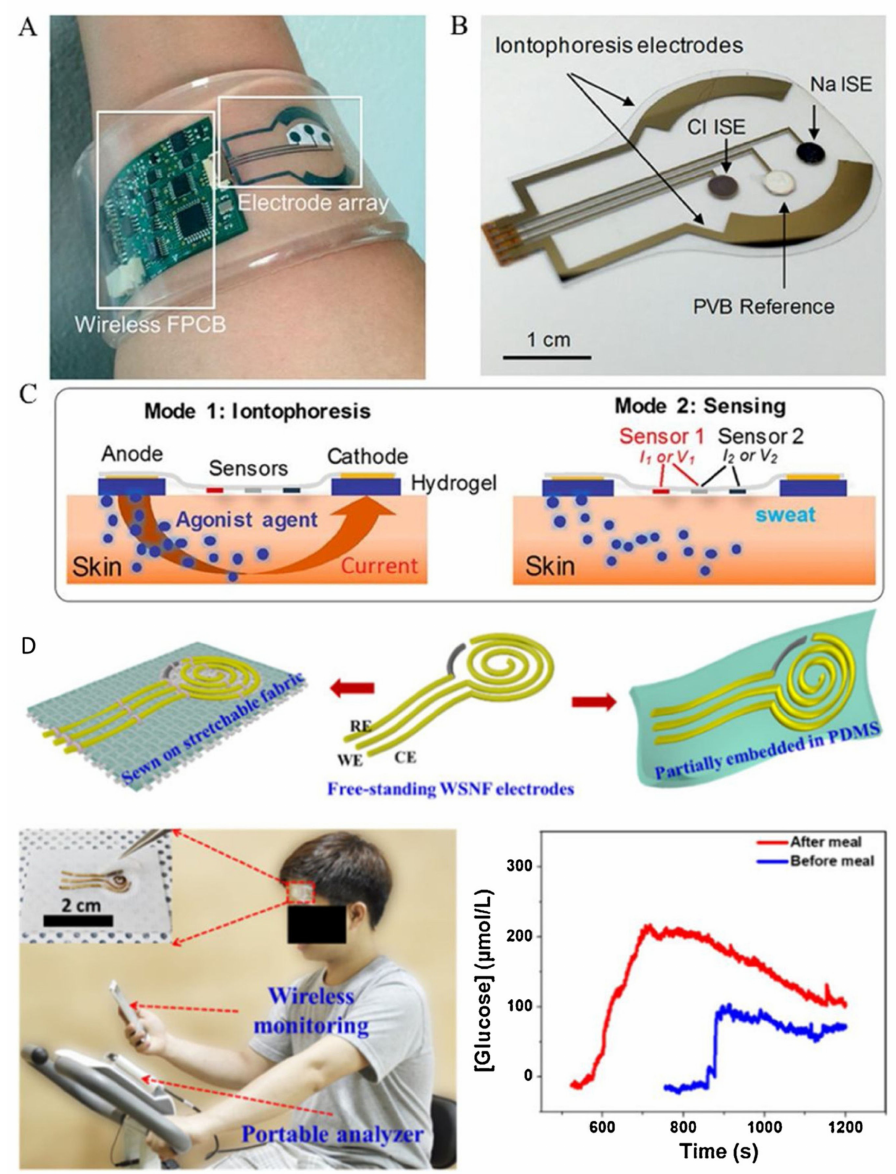
Figure 6. ( A – D ) Examples of perspiration-based wearable glucose sensors. Reproduced from Ref [73] with permission from